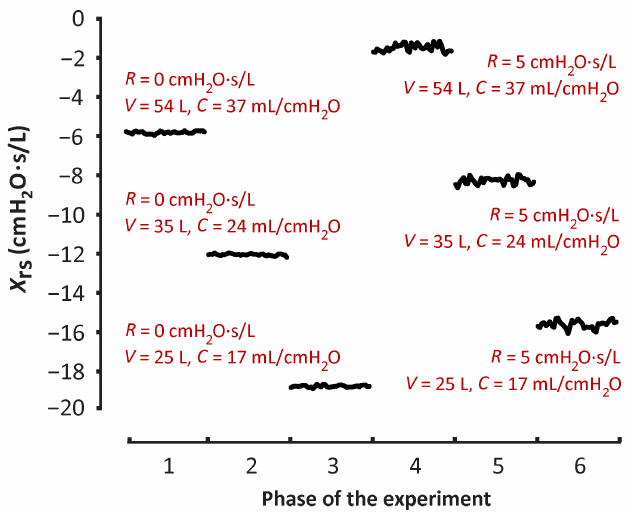
Figure 2. The waveform of X rs when ventilating a model of the respiratory system without an additional resistor ( R = 0 cmH 2 O · s/L) and with an additional resistor ( R = 5 cmH 2 O · s/L). Three glass containers with different volumes (25, 35, and 54 L) were ventilated with and without the resistor to mimic various compliance of the respiratory system.